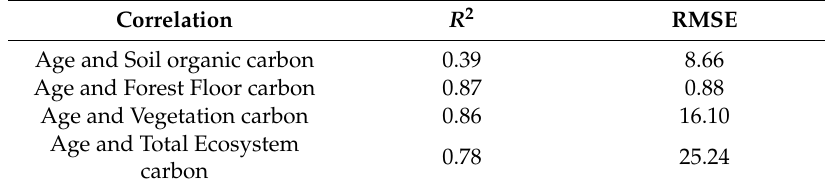
Table 6. Regression equation for age groups (year) and soil organic carbon (Mg ha − 1 ), forest floor